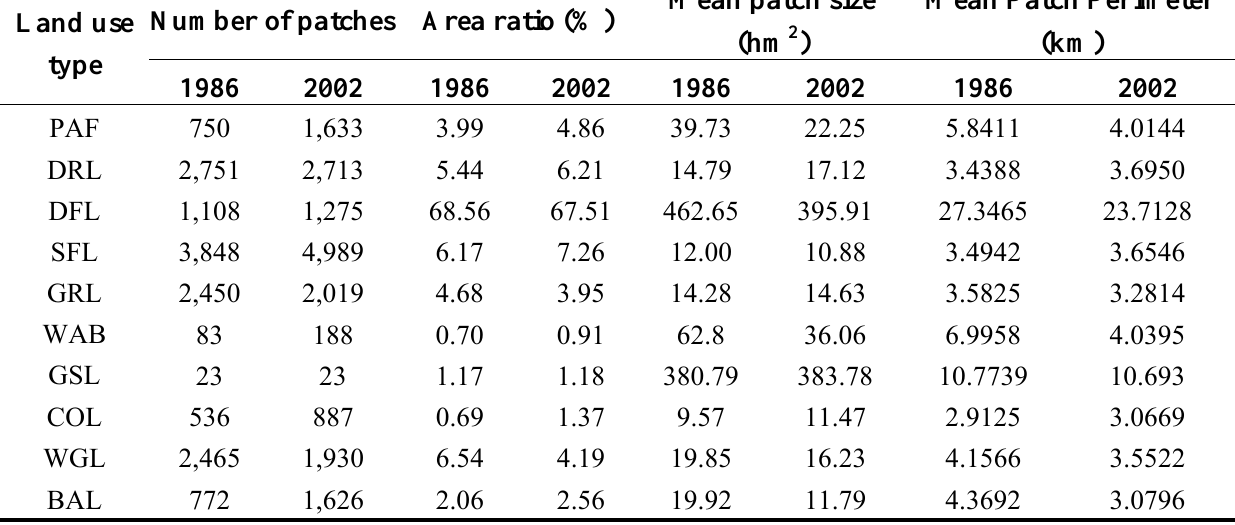
Table 1. The change of number of patches, area ratio, and mean patch size and perimeter in different land use types in Lijiang County during 1986-2002.